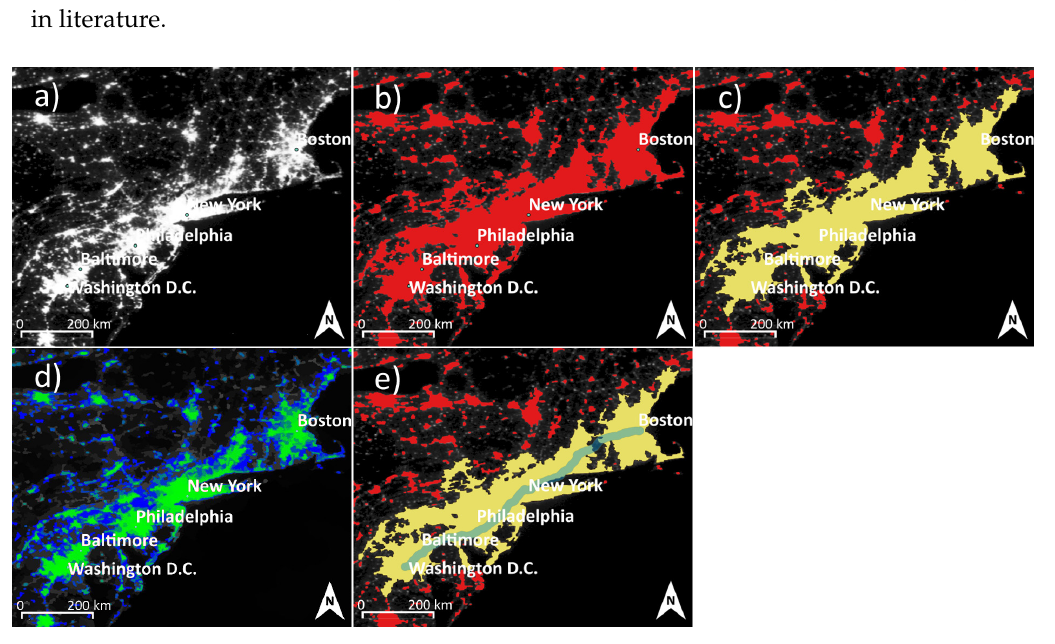
Figure 2. The Boswash urban corridor: ( a ) raw night-time imagery; ( b ) classified urban areas; ( c ) corridor patch (merged); ( d ) threshold derived for Boswash; ( e ) road connection Boston to